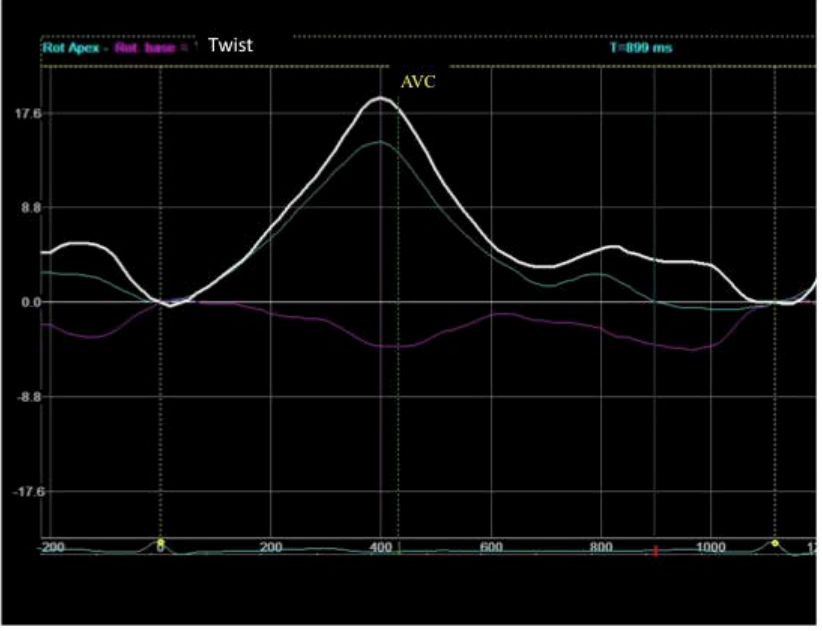
Figure 7. The simultaneous rotation in opposite directions of the base and the apex can be observed in the representation of the twist of a healthy adult subject obtained with EST.